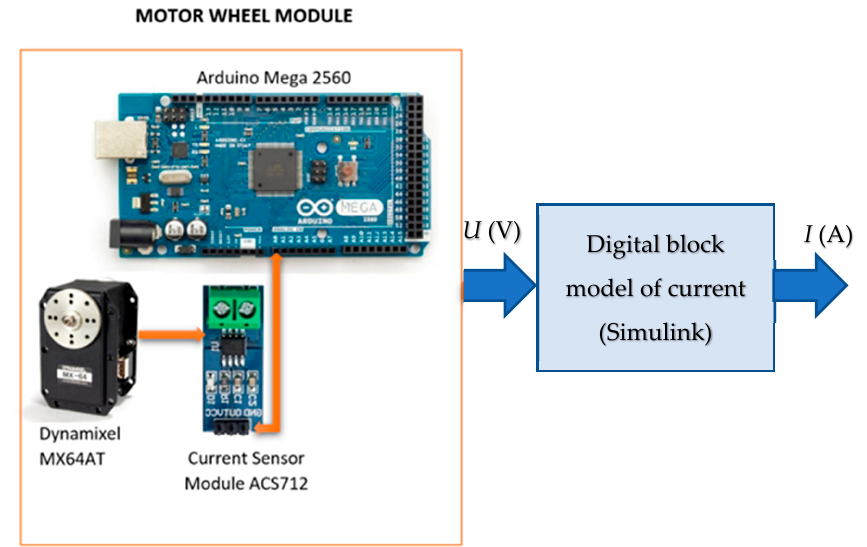
Figure 12. Data acquisition scheme of the drive wheel module and connection with Matalb/Simulink using 10-bit ADC.